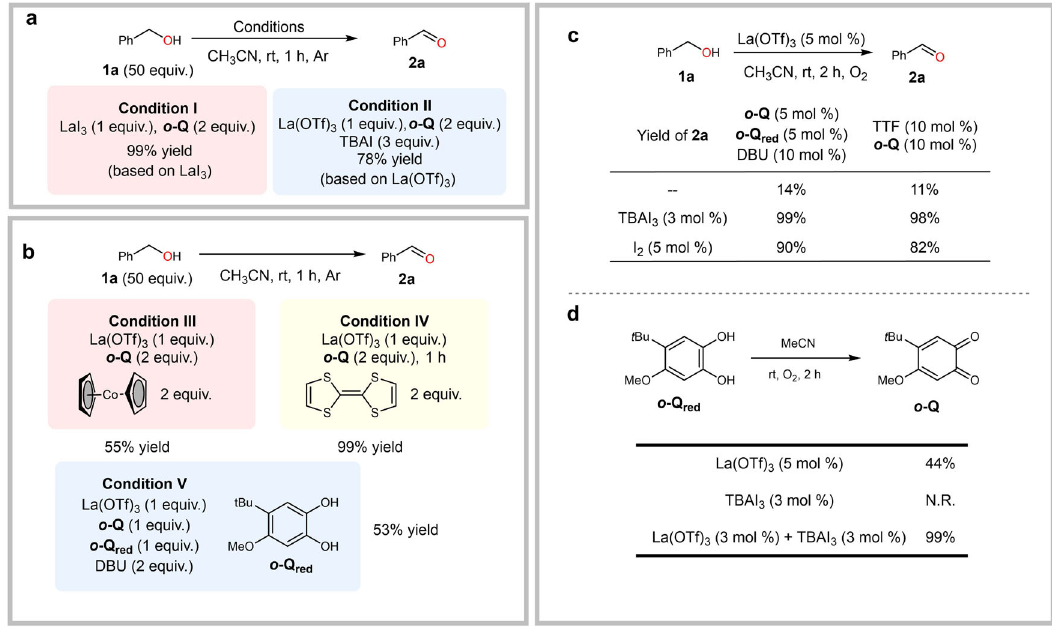
Fig. 5 Control experiment. a Stochiometric reactions. b Other in situ generated semiquinone species control experiments. Yields were based on the amount of La 3 + . c , d Role of iodine. TTF = tetrathiafulvalene. DBU = 1,8-diazabicyclo[5.4.0]undec-7-ene. TBAI 3 = tetrabutylammonium